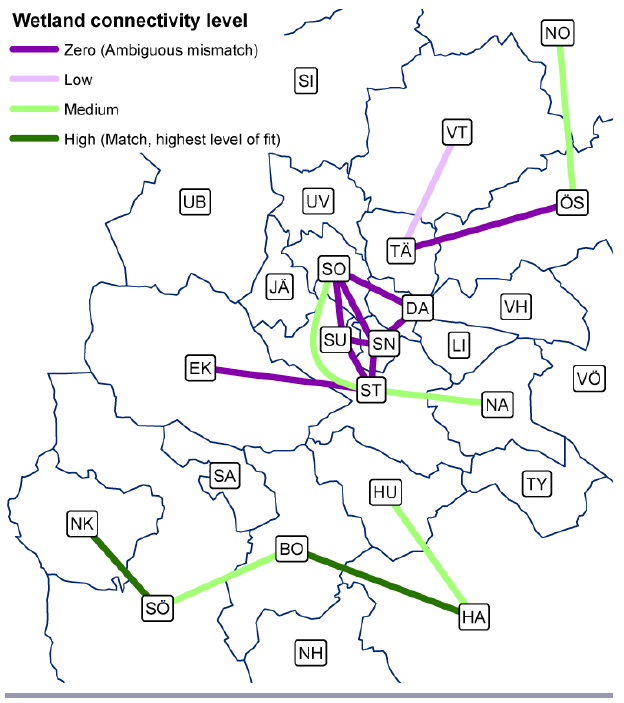
Fig. 6 . Collaborations matched to wetland connectivity (displaying only collaboration links between neighboring municipalities). A links represents wetland connectivity matched by collaboration. Link color represents the level of fit interpreted as the estimated importance of the collaboration tie when it comes to protecting wetland connectivity. For a green link, ending the collaboration has potentially severe impacts on wetland connectivity, whereas for a purple link, it would have little or no impact. The names of the municipalities are abbreviated as follows: BO = Botkyrka, DA = Danderyd, EK = Ekerö, HA = Haninge, HU = Huddinge, JÄ = Järfälla, LI = Lidingö, NA = Nacka, NO = Norrtälje, NK = Nykvarn, NH = Nynäshamn, SA = Salem, SI = Sigtuna, SO = Sollentuna, SN = Solna, ST = Stockholm, SU = Sundbyberg, SÖ = Södertälje, TY = Tyresö, TÄ = Täby, UV = Upplands Väsby, UB = Upplands-Bro, VT = Vallentuna, VH = Vaxholm, VÖ = Värmdö, ÖS = Österåker.